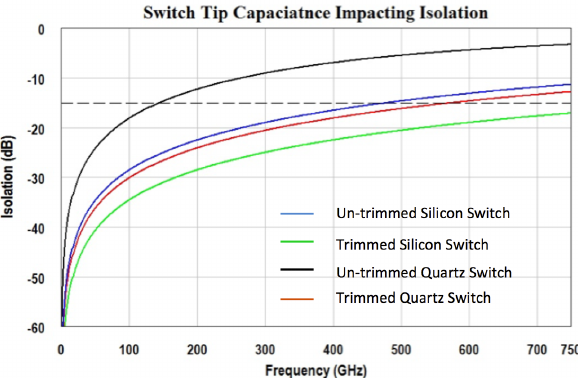
Figure 8. Estimated switch isolation performance dominated by actuator tip capacitance.